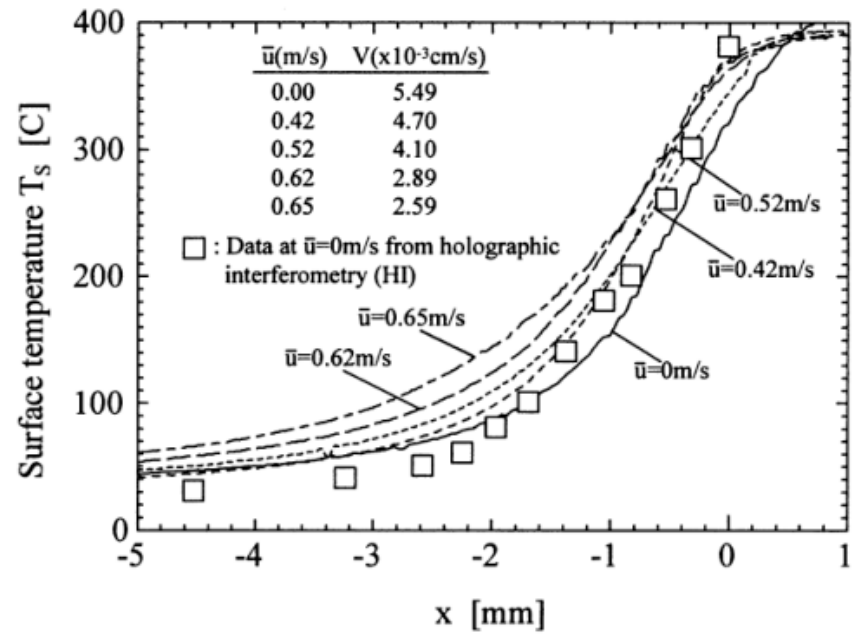
Figure 13. Surface temperature distributions measured by thermography [127]. Figure 17. Surface temperature distributions measured by thermography [127]. Figure 17. Surface temperature distributions measured by thermography [127].